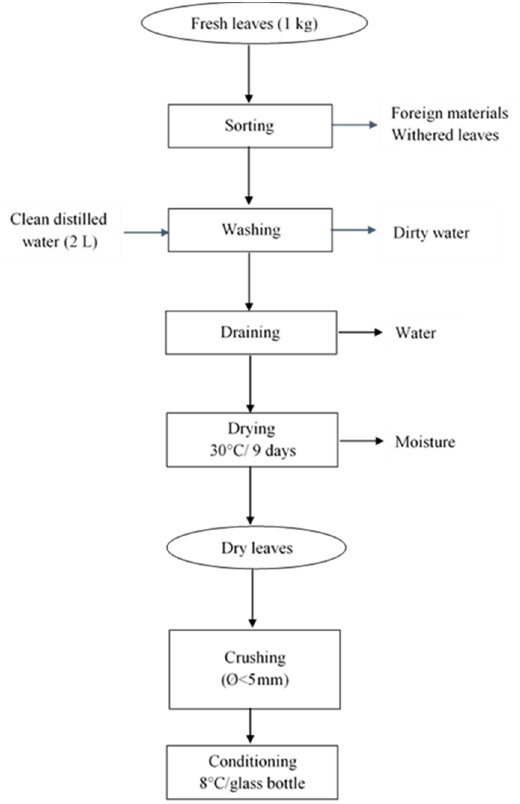
Figure 5. Processing of Vernonia amygdalina leaves.